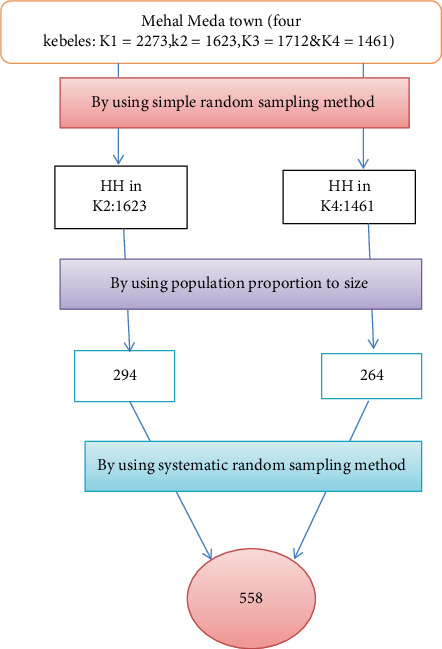
Schematic representation of sampling procedure for assessment of latrine utilization and associated factors in Mehal Meda town in North Shewa zone, Amhara region, Ethiopia, 2019.